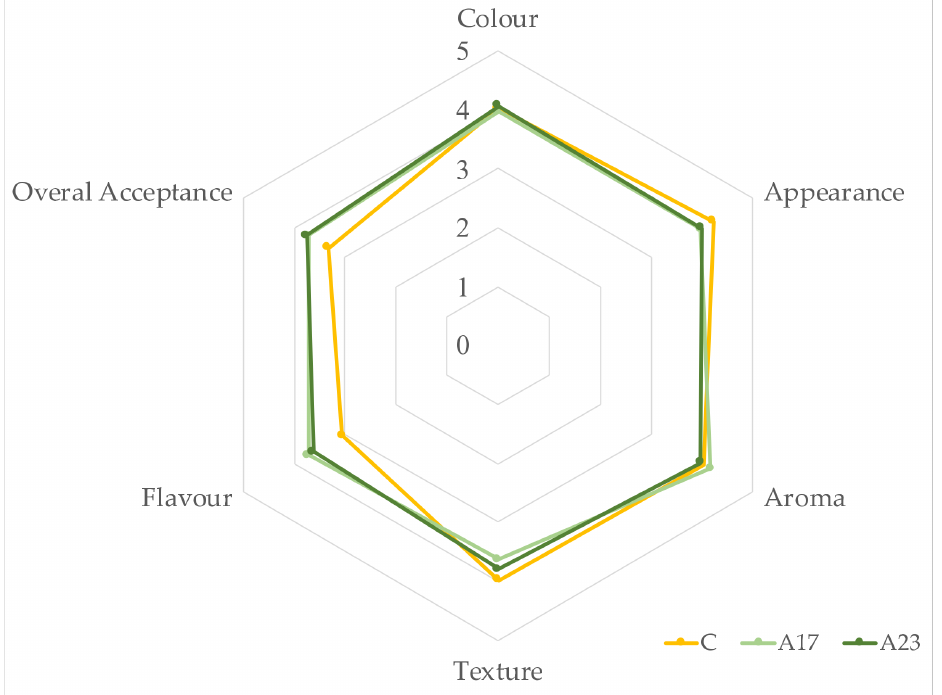
Figure 3. GF breads: Sensorial analysis of sweet GFB, respectively (C) control, without apple flour, (A17) with 17%, and (A23) with 23% of apple flour